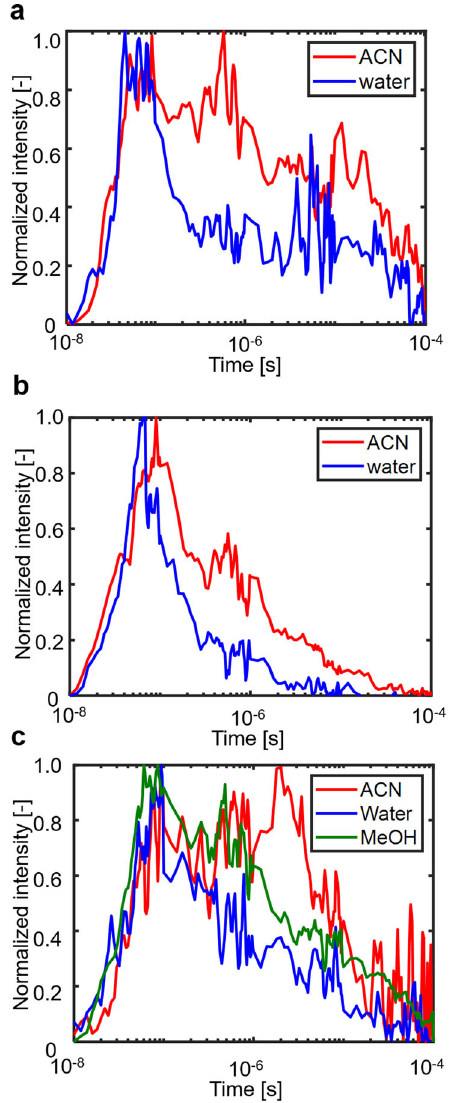
Fig. 2 Average refractive index change responses. a SrTiO 3 :Rh/ITO/ BiVO 4 :Mo, b BiVO 4 :Mo only, and c SrTiO 3 :Rh only until 100 μ s in acetonitrile (ACN) and water obtained from the image sequence obtained by the patterned-illumination time-resolved phase microscope. (red: in ACN, blue: in water) The response was obtained from the signal amplitude at the light irradiated regions. The response in methanol (MeOH) is also shown for c STOR only (green: in MeOH).